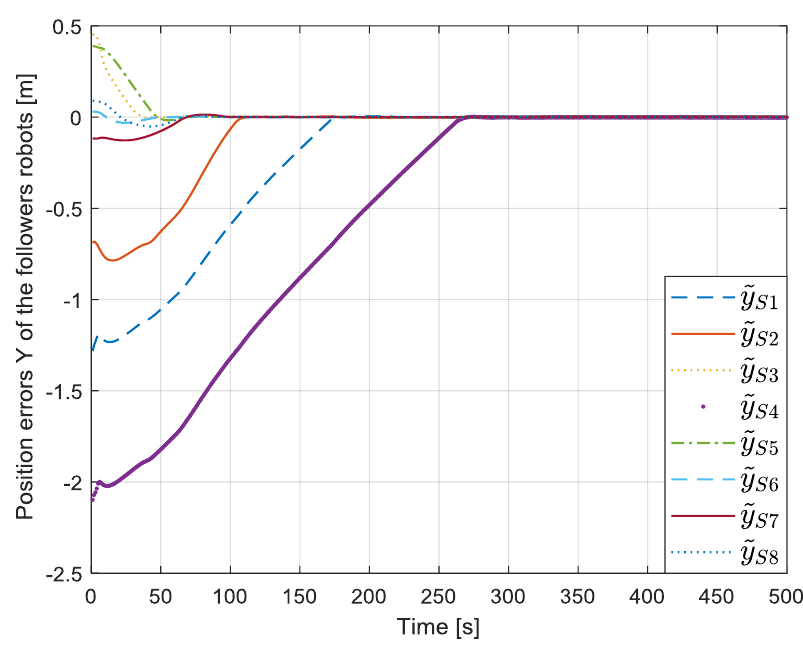
Figure 18. Position errors Y of the follower